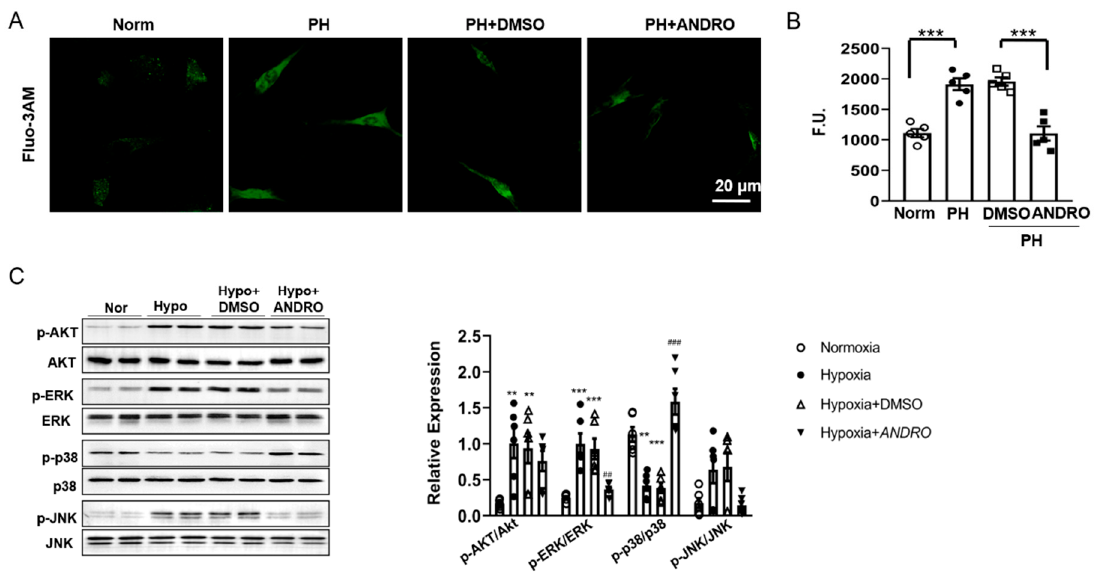
Figure 7. Effect of ANDRO on [Ca 2+ ] i , and related signaling pathways. ( A , B ) Representative image ( A ) and group data ( B ) showing that ANDRO significantly reduced [Ca 2+ ] i elevation in PH-PASMCs compared to healthy PASMC ( n = 18 from five independent experiments). Scale bars are 20 μ m. ( C ) Western blot analysis showing the effects of ANDRO on phosphorylation of AKT, ERK, p38 and JNK. n = 6. Data represent mean ± SEM. ** p < 0.01, *** p < 0.001 vs. control; ## p < 0.01, ### p < 0.001 vs. PH-DMSO.